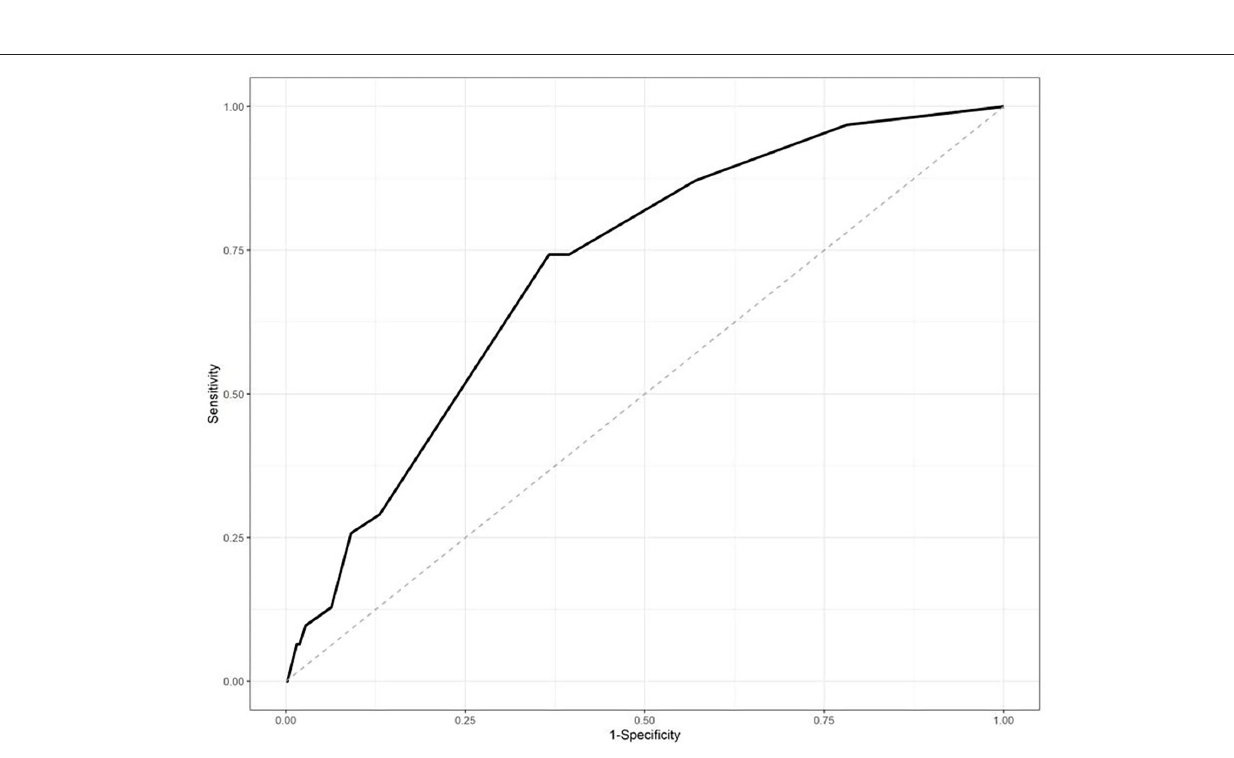
Frontiers in Medicine |